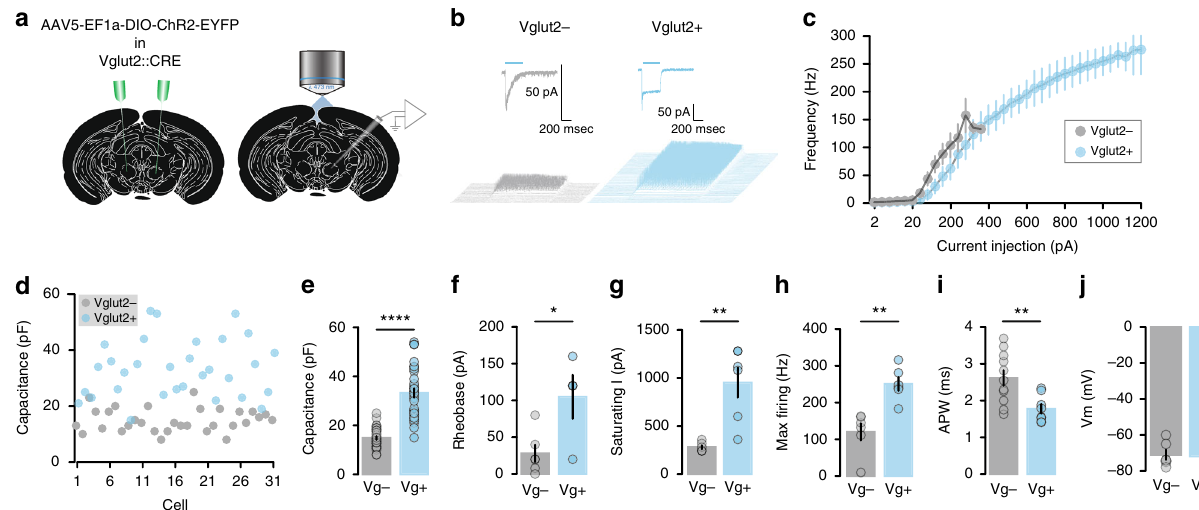
Fig. 4 Vglut2-positive cells exhibit speci fi c intrinsic properties. a Schematic of viral injection of ChR2-eYFP in Vglut2-CRE RN and in vitro whole-cell patch- clamp recordings. b Light induced-currents and fi ring activity in identi fi ed cells. c Input-output curves ( n = 6 cells/group). d Capacitance distribution of Vglut2-positive and Vglut2-negative cells ( n = 31 cells/group). e Capacitance, t (60) = 9.12, P < 0.0001. f Rheobase, t (8) = 2.77, P = 0.0244 ( n = 8 – 12 cells/group). g Saturating current, t( 10) = 4.27, P = 0.0016. h Maximal fi ring, t (10) = 4.38, P = 0.0014. i Action potential width, t (17) = 3.01, P = 0.0067. j Resting membrane potential. ( n = 6 cells/group). All data are reported as mean and SEM. Data obtained from photo-identi fi ed Vglut2-positive neurons are shown in blue (Vg + ) whereas those light-insensitive Vglut2-negative neurons are displayed in grey (Vg − )